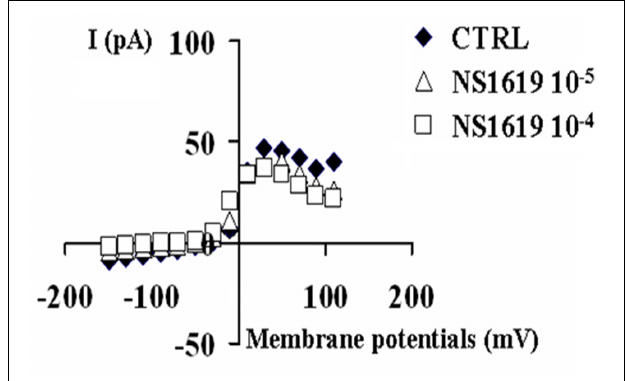
FIGURE 3 | Effects of the BKCa channel opener NS1619 on K + -current recorded in SH-SY5Y neuronal cell line. The effects of the NS1619 (10 × 10 − 6 M and 100 × 10 − 6 M) were investigated on the K + -current recorded in asymmetrical K + ions concentrations (int K + : 132 × 10 − 3 M; ext K + : 2.8 × 10 − 3 M), in the presence of internal 1.6 × 10 − 6 M concentration of free Ca 2 + ions, in the range of potentials going from − 150 to + 110mV, HP = − 60mV using whole cell patch clamp technique. The K + -current was leak subtracted and normalized to capacitance. The I/V relationship was constructed in the absence (CTRL) or presence of different concentrations of NS1619. In the this experiment, the application of 10 × 10 − 6 M and 100 × 10 − 6 M concentrations of this drug enhanced the K + -channel current, at − 10mV (Vm), respectively by + 41.7 and + 171% with respect to the control.